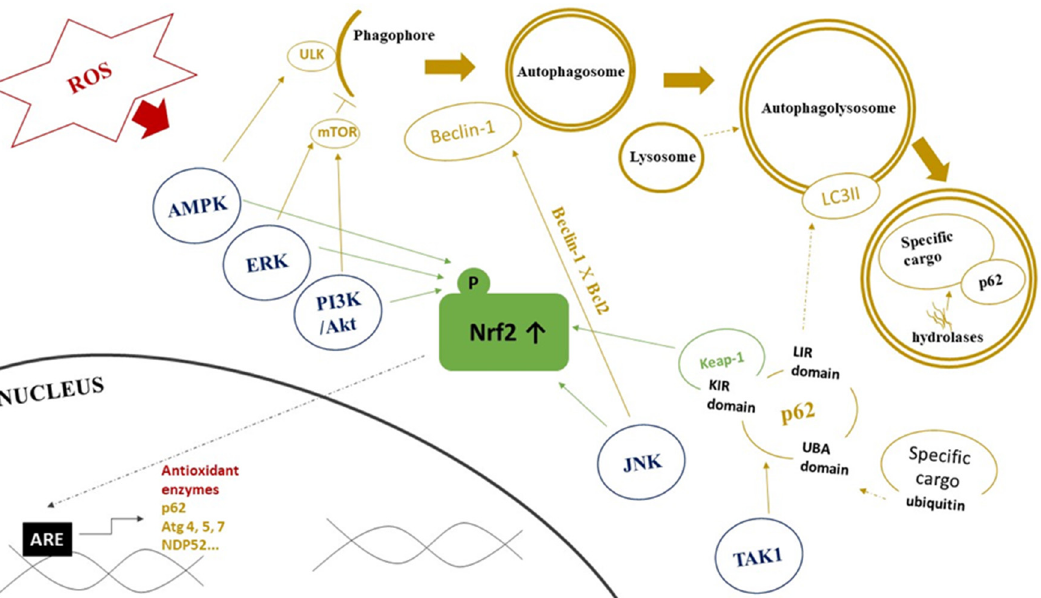
Figure 2. Role of protein kinase pathways in interplay between Nrf2 signaling and autophagy. Abbreviations: ROS—reactive oxygen species, AMPK—AMP-activated protein kinase, ERK—extracellular signal-regulated kinase, PI3K/Akt—phosphatidylinositol 3-kinase/Akt kinase, JNK—c-Jun N-terminal kinase, TAK1—TGF- β -activated kinase 1, ULK—Unc-51-like autophagy activating kinase, mTOR—mammalian target of rapamycin, LC3II—microtubule-associated protein light chain 3-II, UBA domain—ubiquitin-associated domain, KIR domain—KEAP1 interacting region, LIR domain—(LC3)-interacting region, Keap1—kelch-like ECH-associated protein 1, Nrf2—nuclear factor erythroid 2-related factor 2, ARE—antioxidant response element, Atg— AuTophaGy-related proteins. Red color represents components of redox signaling. Blue color represents protein kinases affecting Nrf2 and autophagy. Green color represents components of Nrf2 signaling pathway. Yellow color represents components of autophagy pathway. Dashed line arrows represent the connection/fusion between the two components. Details are provided in the text.